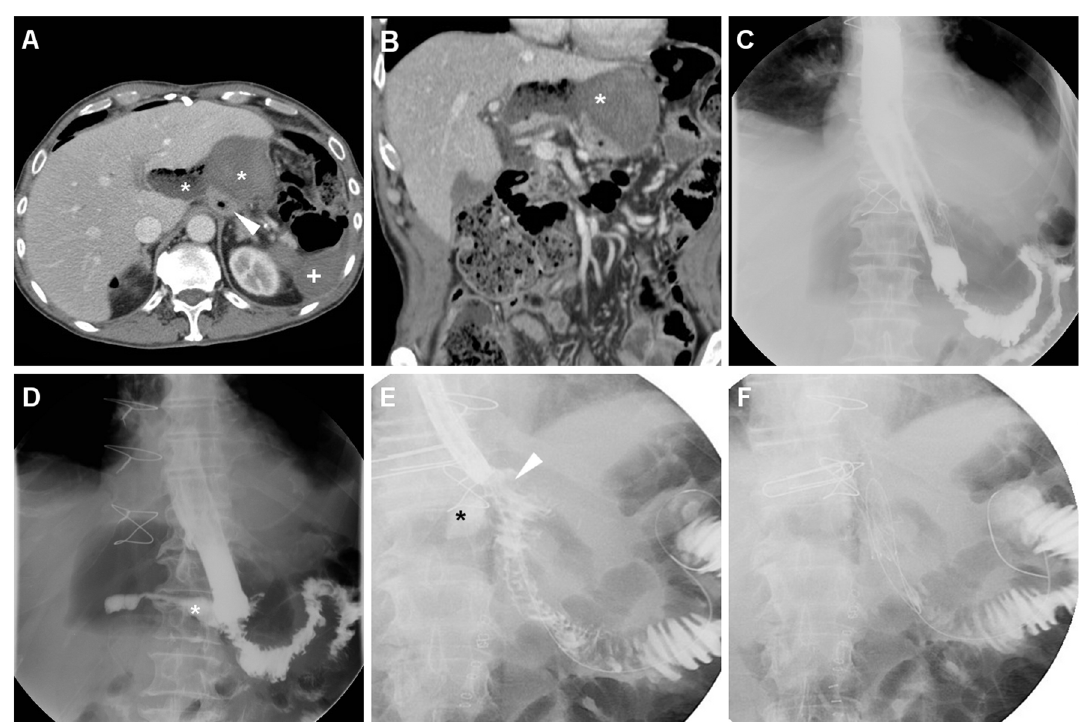
Fig. 11 A 68-year-old male with recurrent gastric carcinoma on previous Billroth II gastrectomy for peptic ulcer was treated with total gastrectomy. Postoperative anemization required blood transfusions. On 12th POD, contrast-enhanced CT (A, B) showed persistent intraperitoneal air, a mixed attenuation collection (*) adjacent to the EJS (arrowheads),